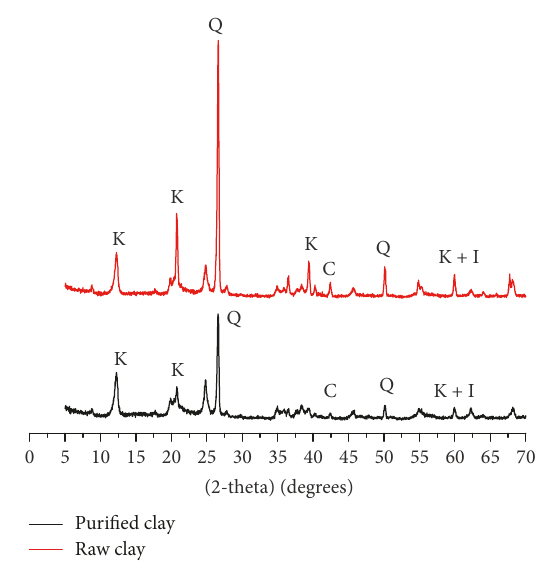
Figure 1: XRD analysis of raw clay and purified clay (K: kaolinite, I: illite, C: calcite, and Q: